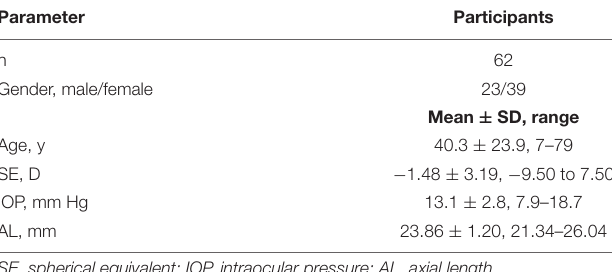
TABLE 1 | Demographic and ocular characteristics of study participants. Parameter